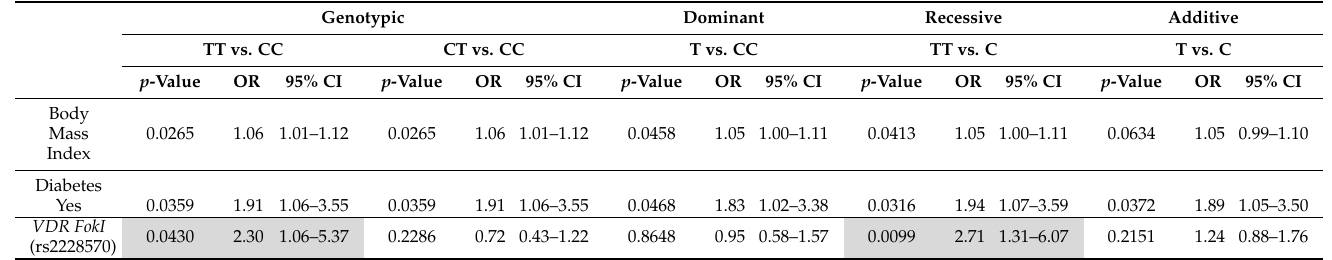
Table 3. Influence of clinical characteristic and VDR FokI (rs2228570) gene polymorphism on risk of cardiovascular